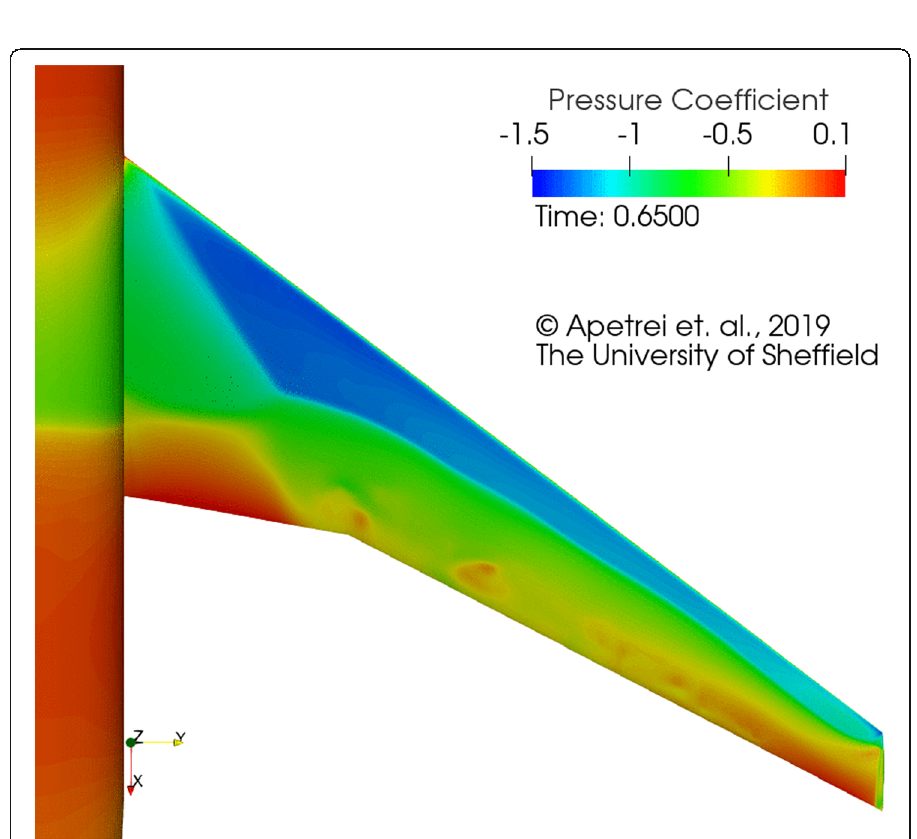
Fig. 11 Surface mean and RMS pressure contours at M = 0.85, Re = 5 m, and α =